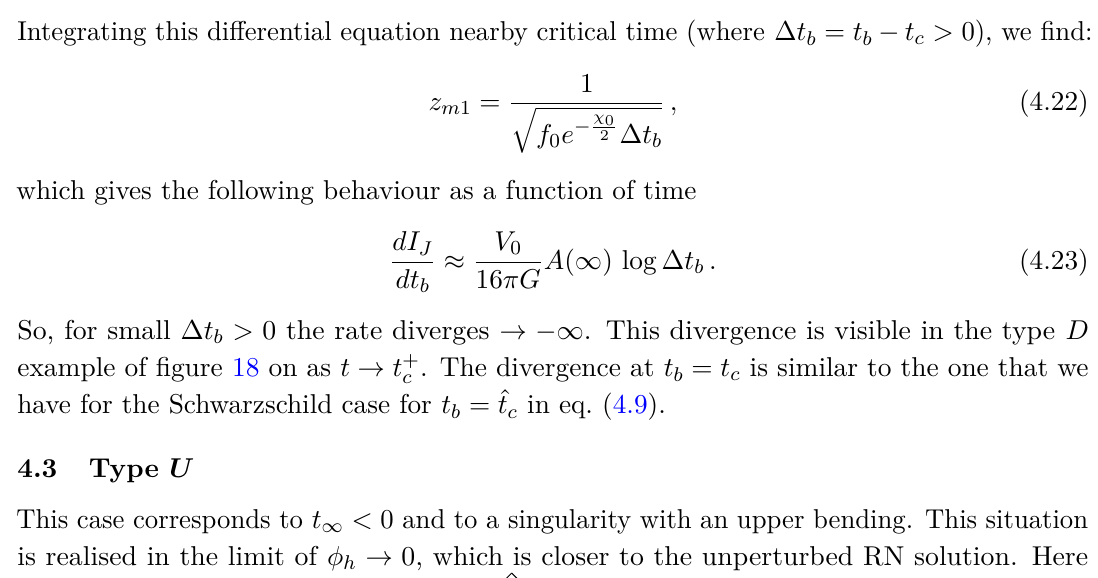
Figure 19 . Critical time for the q = 0 case as function of φ h , for several ρ and z h = 1 . For each curve, the minimum in t c separates the solutons of types U and D. Dashed lines are extrapolations following the law t c = const . × ( φ h /µ ) − 2 . 003 3